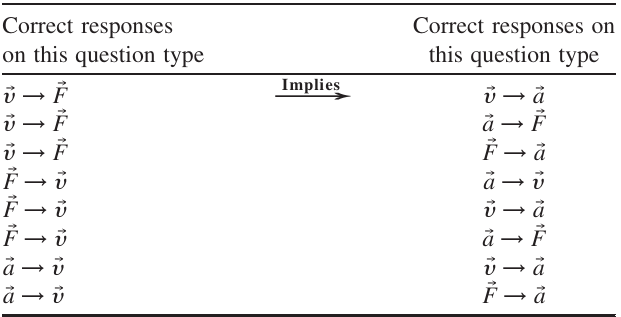
TABLE X. A summary of hierarchy trends suggested by Table